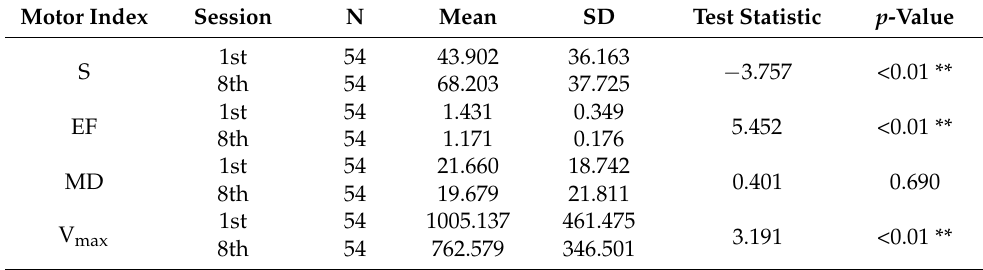
Table 7. Summary statistics and paired t -test for comparing motor indecies in Mode 3 between the first and eighth training for the Tracing task.